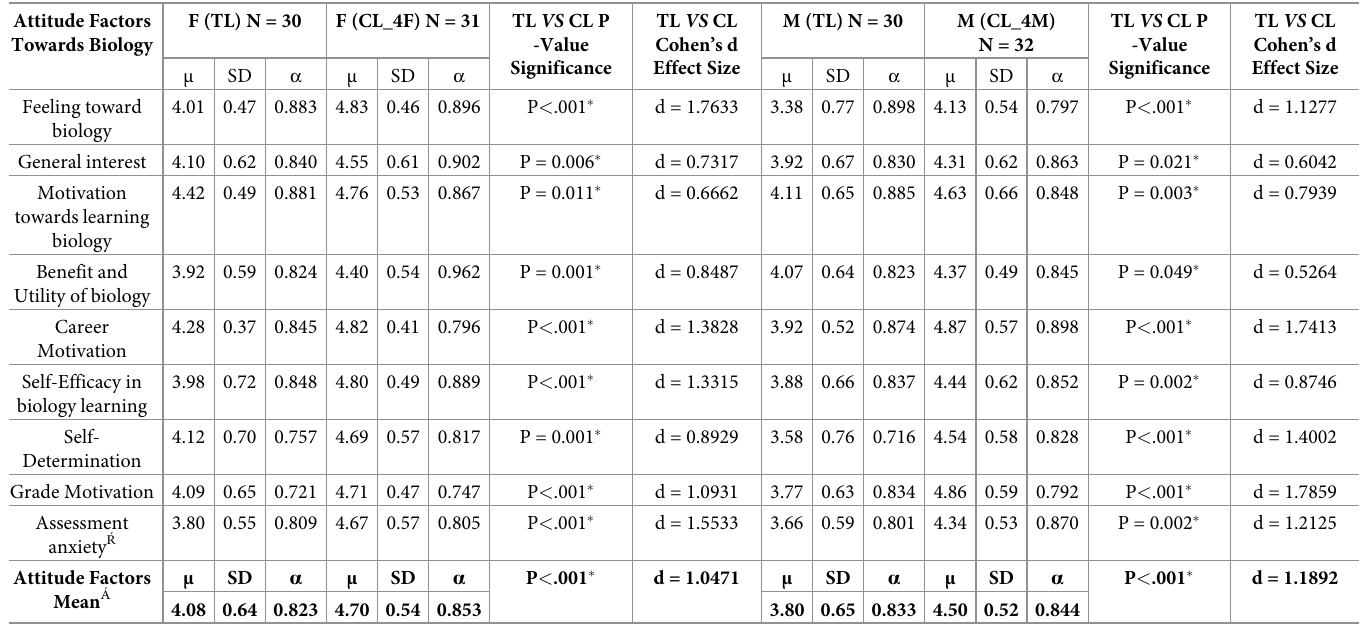
Table 4. Major single-gender biology students’ attitude means, standard deviations, and reliability of attitude scale components for each attitude factor.